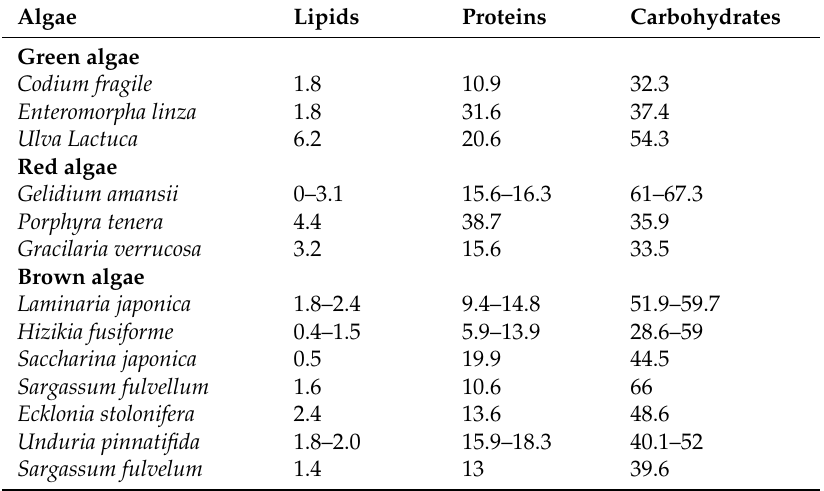
Table 2. Lipid, protein and carbohydrate composition of various seaweeds % dw [135]. Algae